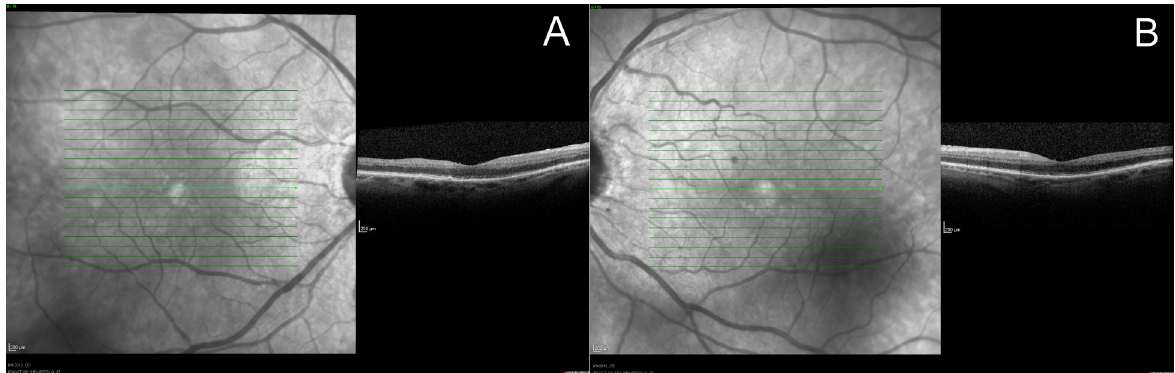
Figure 2: Optical coherence tomography of the right eye (A) and the left eye (B) without evidence of macular edema